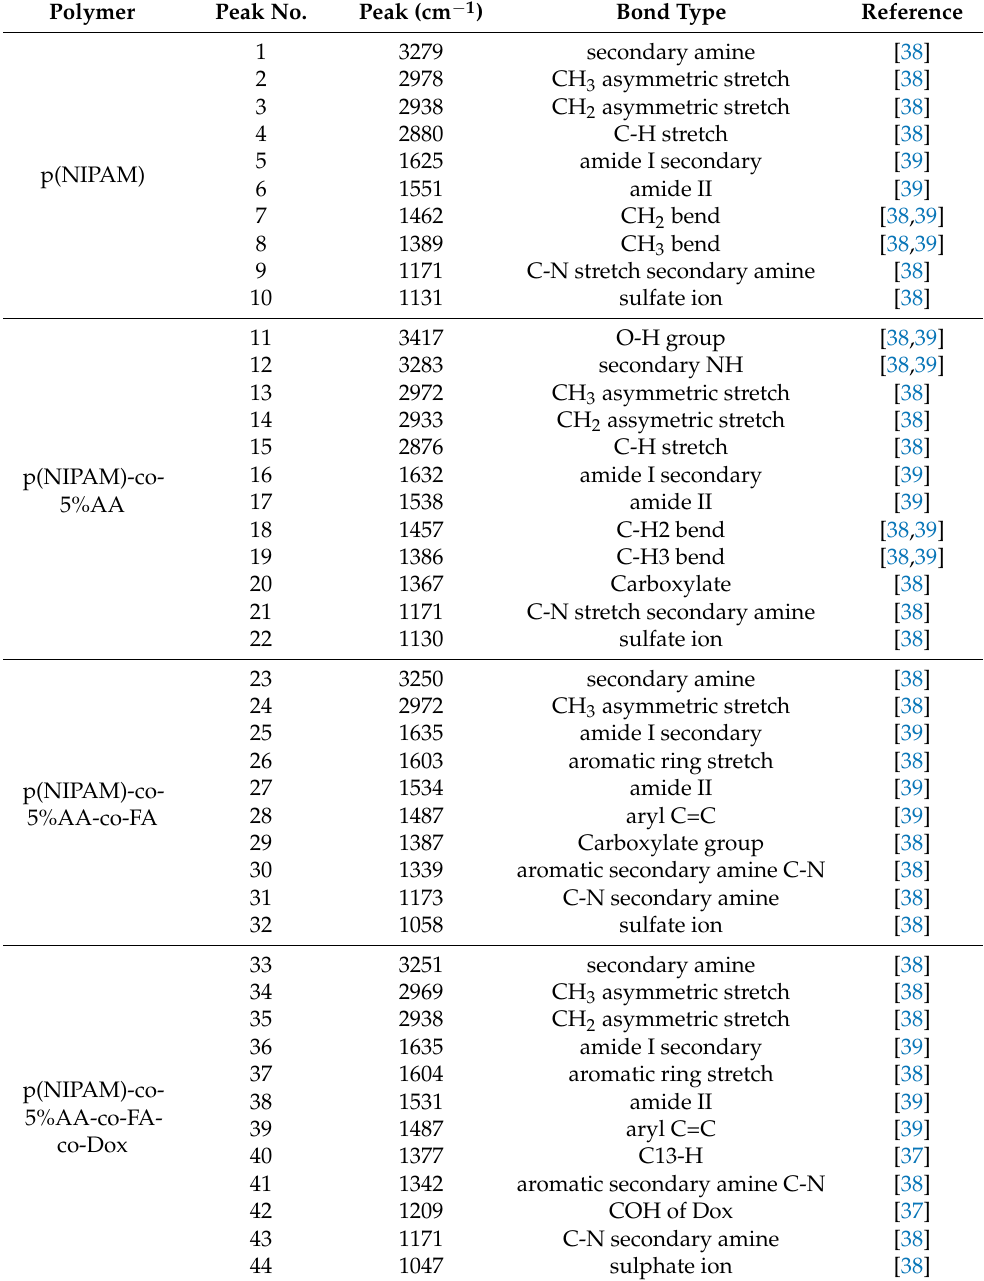
Table 1. FTIR peaks of p(NIPAM), p(NIPAM)-co-5%AA, p(NIPAM)-co-5%AA-co-FA, and p(NIPAM)- co-5%AA-co-FA-co-Dox and their assignments with references. Polymer Peak